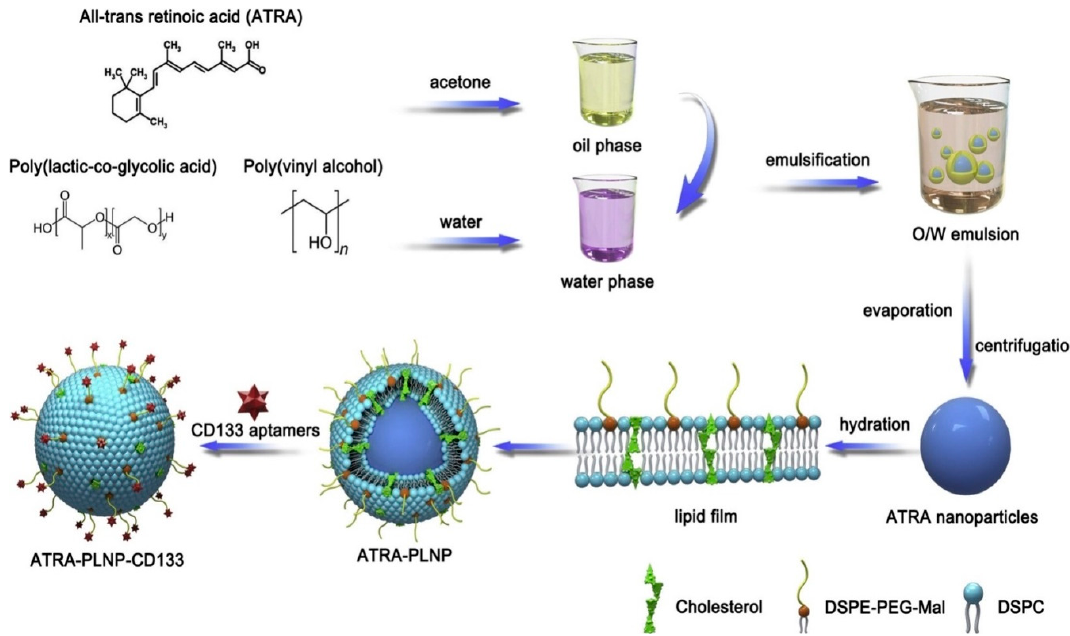
Figure 9. The synthesis of CD133 aptamer-conjugated all-trans-retinoic acid (ATRA) carrying PLHNPs. Reproduced with permission from [116], under Creative Common Attribution 4.0 International